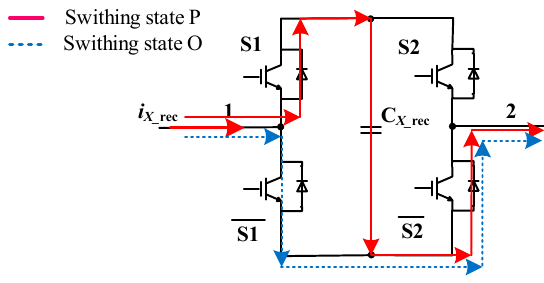
Figure 5. Current paths of S1S2 when i X _rec > 0 and ( u *X _rec − u z_rec ) > 0. Figure 5. Voltage balancing algorithm of C X _rec . Table 3. Value of u z_rec . Table 3. Value of z_rec u